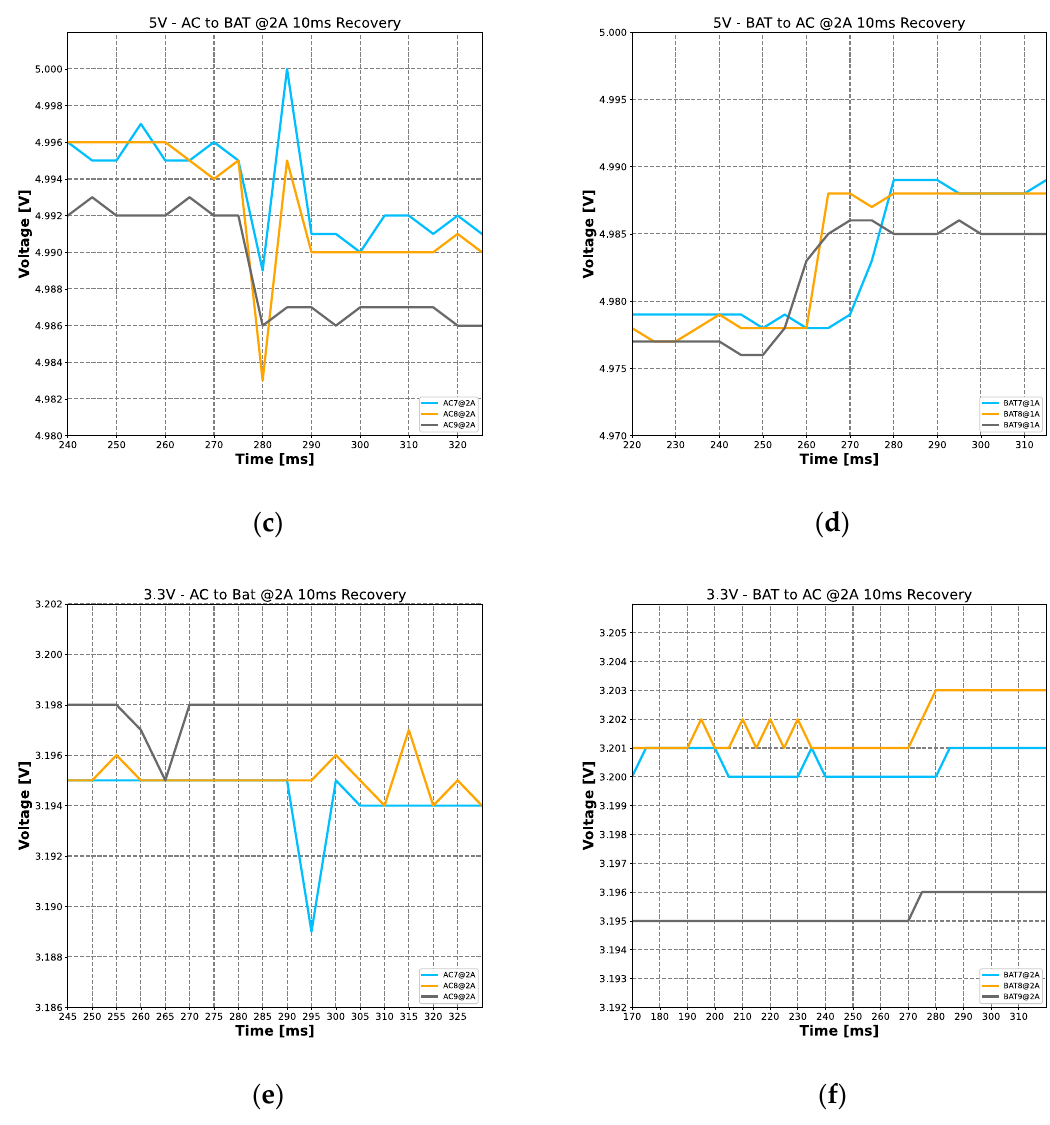
Figure 14. Graph of ( a ) Switching between AC and battery on 12 V with 2 A, ( b ) Switching between battery and AC on 12 V with 2 A, ( c ) Switching between AC and battery on 5 V with 2 A, ( d ) Switching between battery and AC on 5 V with 2 A, ( e ) Switching between AC and battery on 3.3 V with 2 A, ( f ) Switching between battery and AC on 3.3 V with 2 A.